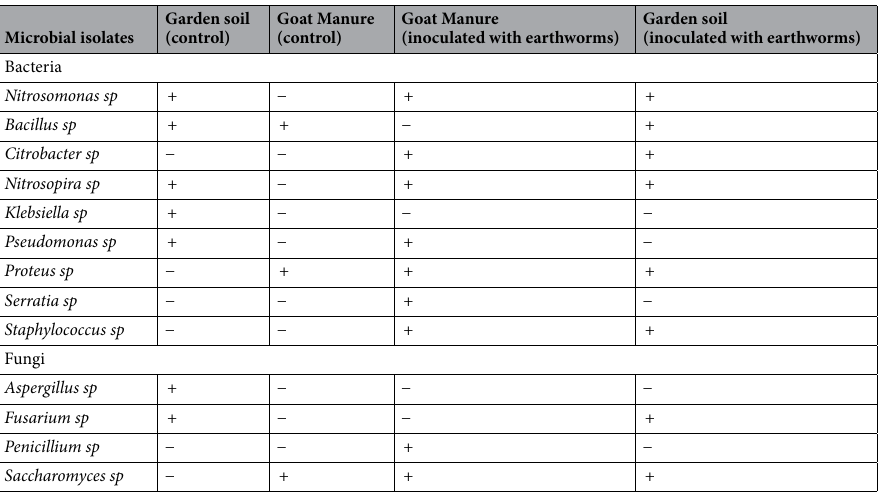
Table 1. Distributions of microbial isolates in the different cast-types.